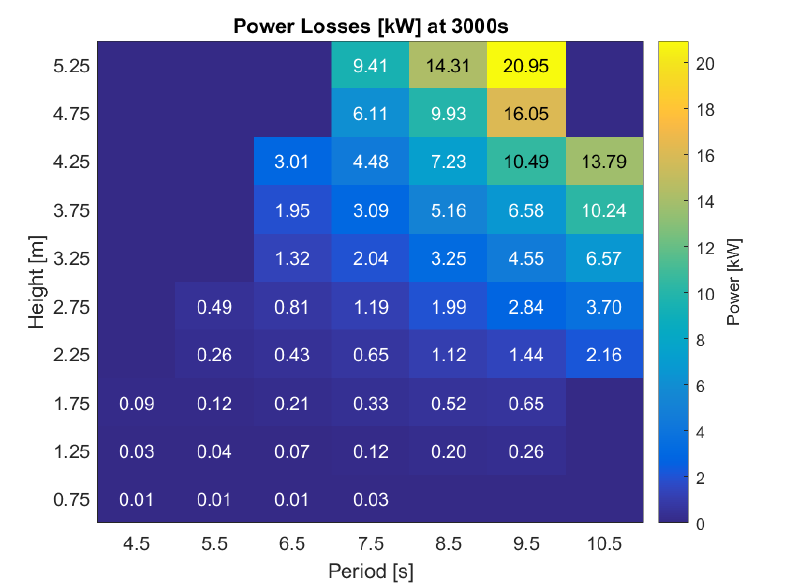
Figure 5. The intercepted power ( P icp ) matrix for each wave condition calculated by WEC–Sim. The largest power generation can be found for the largest wave conditions.